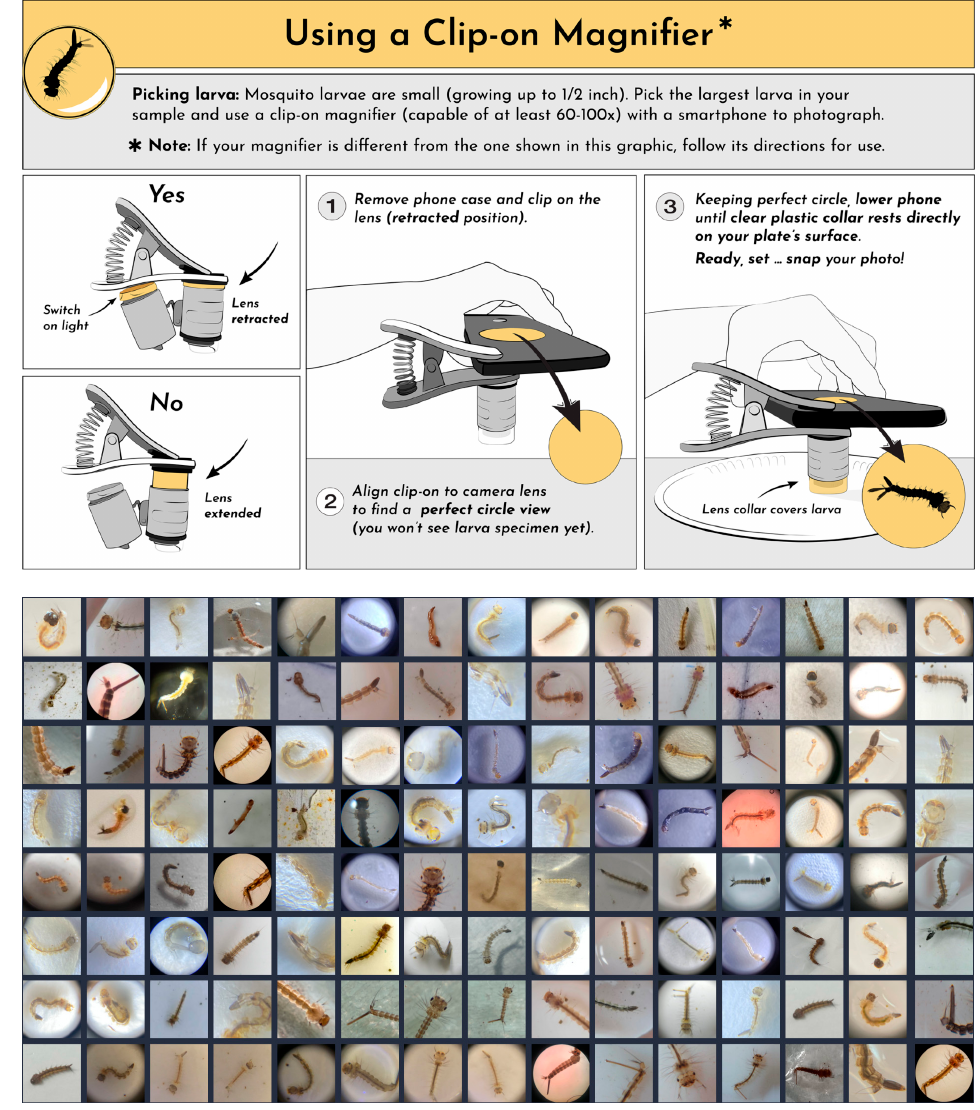
Figure 2. Images from the Mosquito Habitat Mapper’s 2021 Mosquito Habitat Photo Challenge. ( Top ) Panel from the instructional materials for citizen scientists, demonstrating the proper way to use an inexpensive 60x clip-on lens with a smartphone to photograph mosquito larvae. The full two-page PDF is included as File S1. ( Bottom ) A selection of citizen science images submitted through the Mosquito Habitat Mapper app during the challenge.